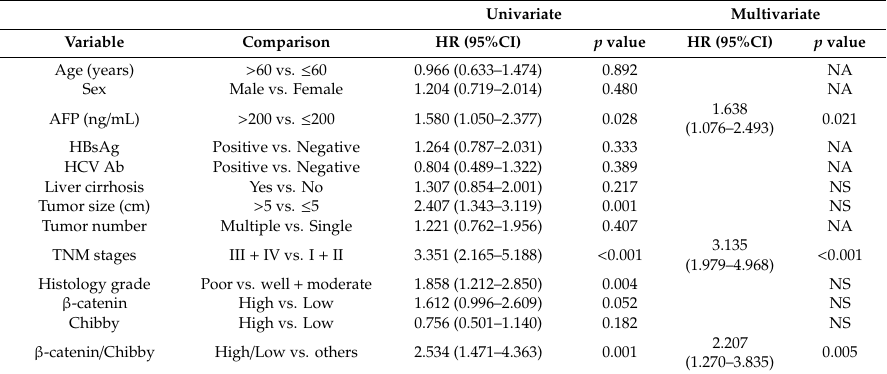
Table 3. Univariate and multivariate analysis of factors associated with overall